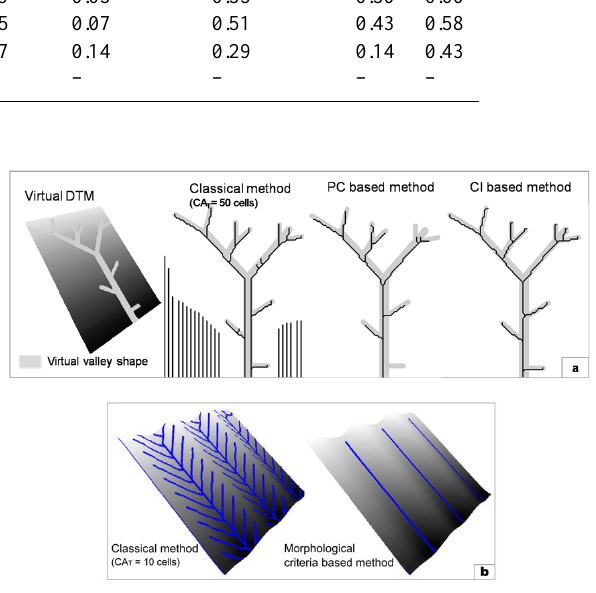
Figure 5. Examples of thalweg networks extracted from two artificial DTMs: a) a virtual 3 Fig. 5. Examples of thalweg networks extracted from two artifi- catchment DTM; (b) a simple corrugated surface. 4 cial DTMs: (a) a virtual catchment DTM; (b) a simple corrugated